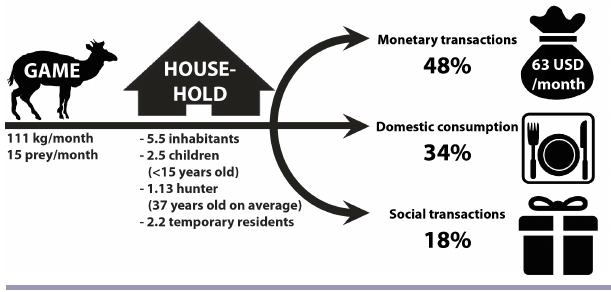
Fig. 3 . Synthesis of the bushmeat procurement quantitative survey carried out in a Fang village in 1990-91. Percentages